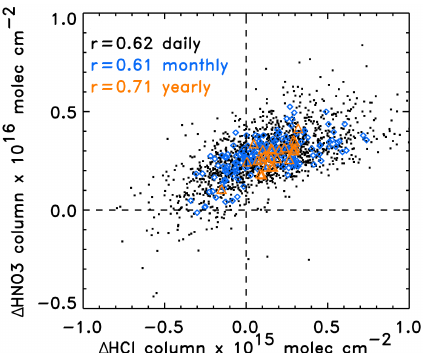
Figure 12. The differences between observed and simulated Lauder HCl columns are correlated with the differences between observed and simulated HNO 3 columns, whether considering daily values (black), monthly averages (blue) or yearly averages